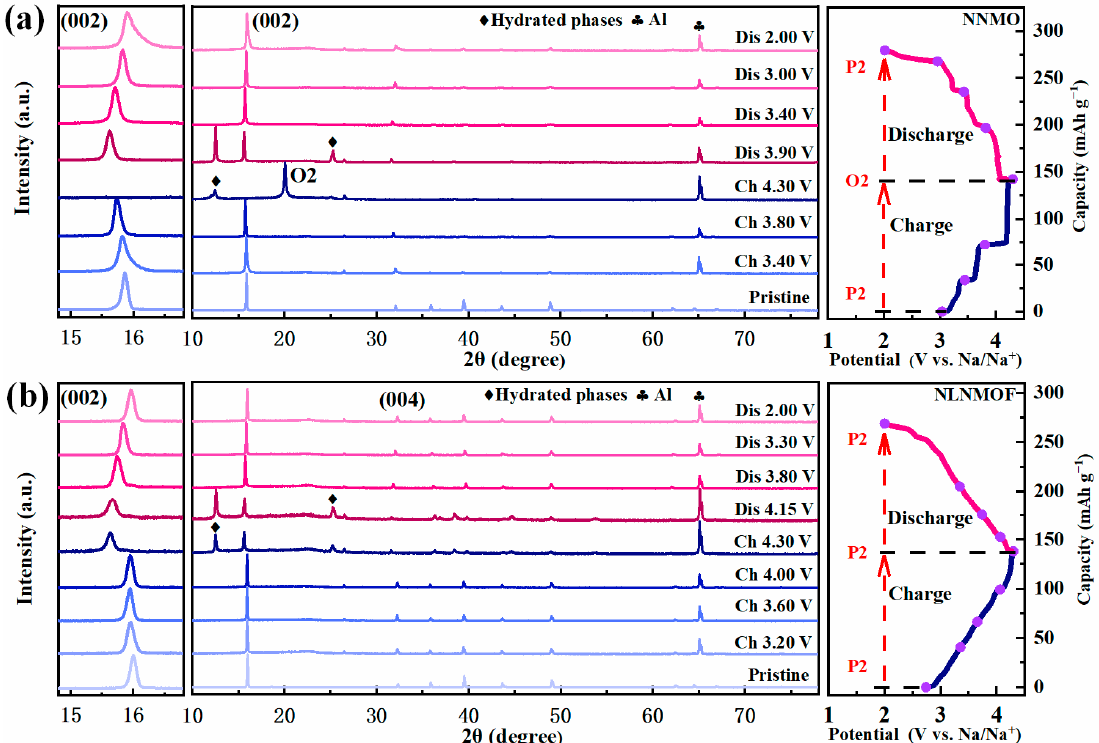
Figure 4. Ex situ XRD patterns acquired on electrodes retrieved from cells stopped at different stages during the first cycle of ( a ) NNMO and ( b ) NLNMOF electrodes.